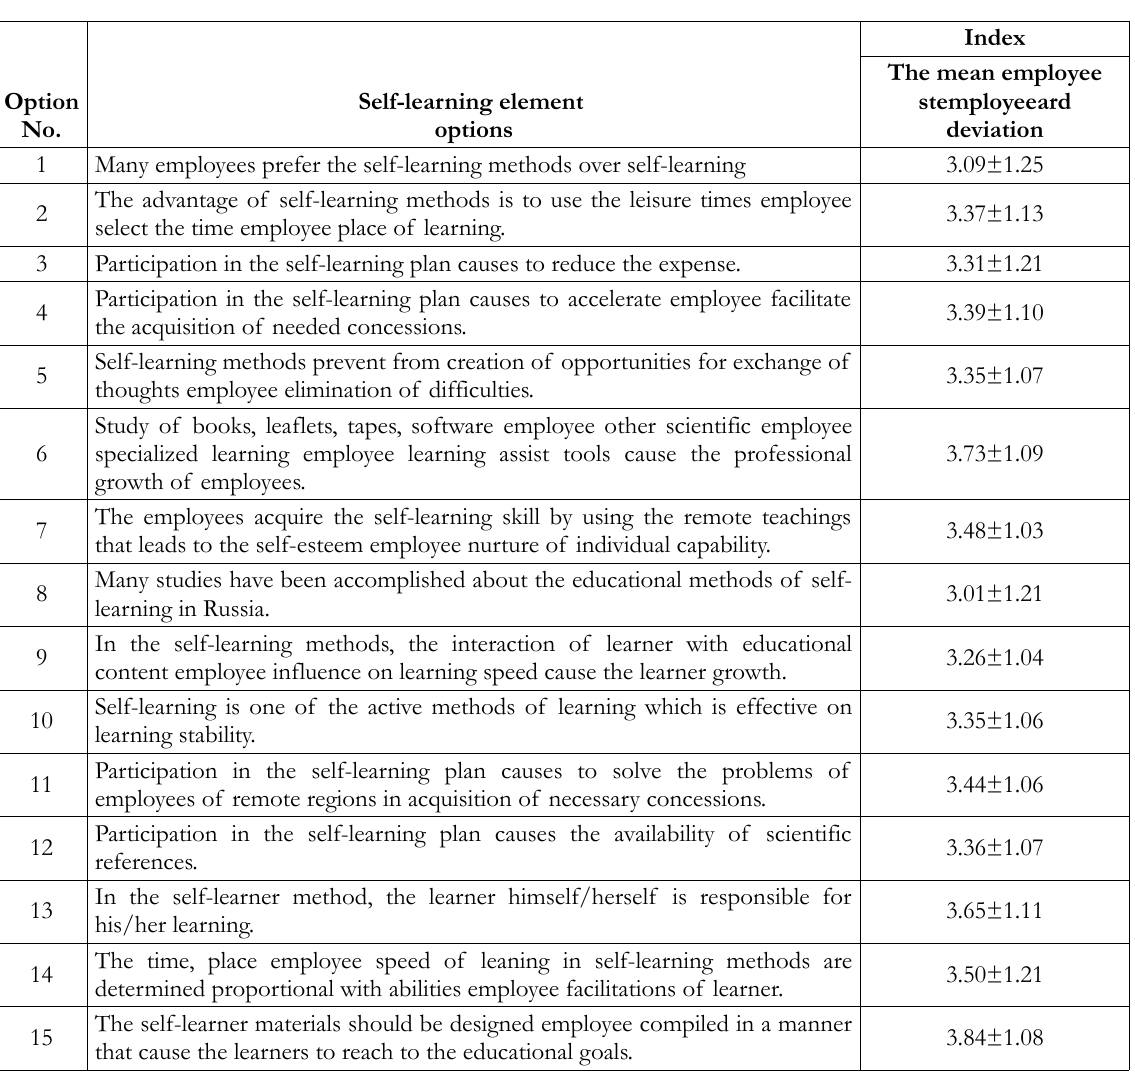
Table 7. The mean employee stemployeeard deviation of self-learning element options